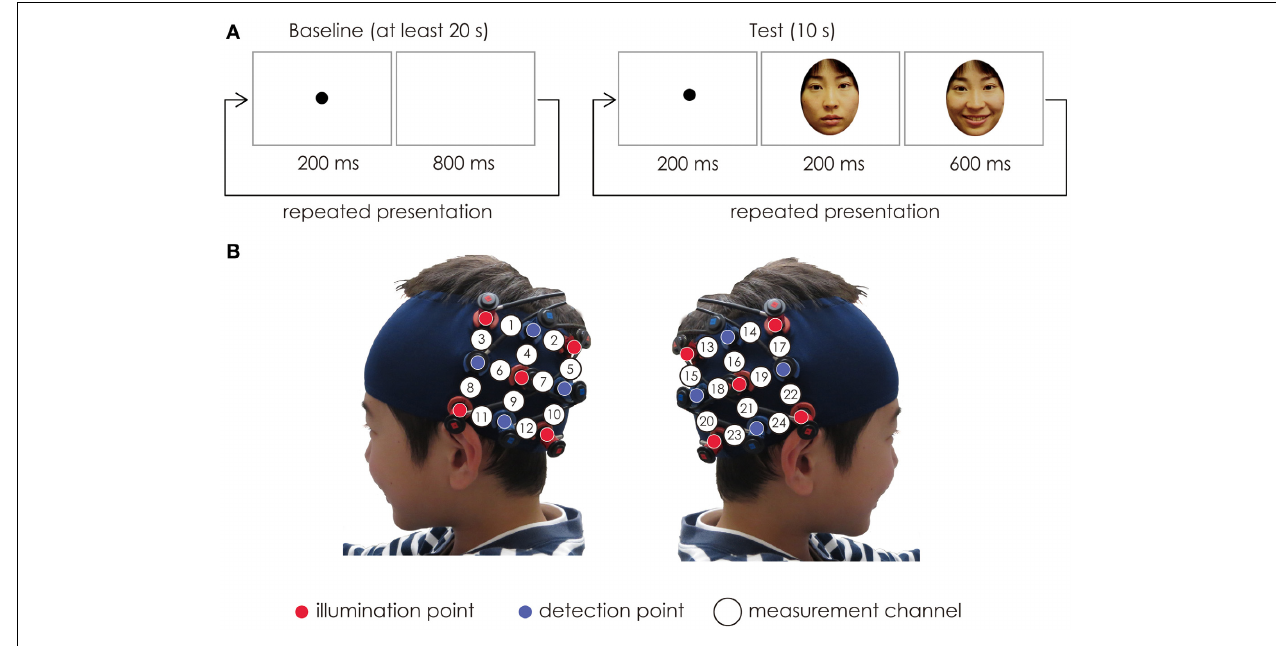
FIGURE 1 | (A) The stimuli sequence. In each trial, the baseline period consisted of the black dot, and its duration was at least 20s. The test period consisted of a happy expression of the mother’s face. The duration of the test period was fixed for 10s. The baseline period and test period were